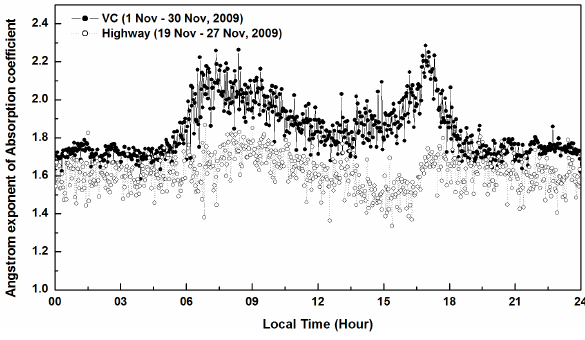
Fig. 10. Diurnal variation of Angstrom exponent of absorption co- efficient at village center (VC) and